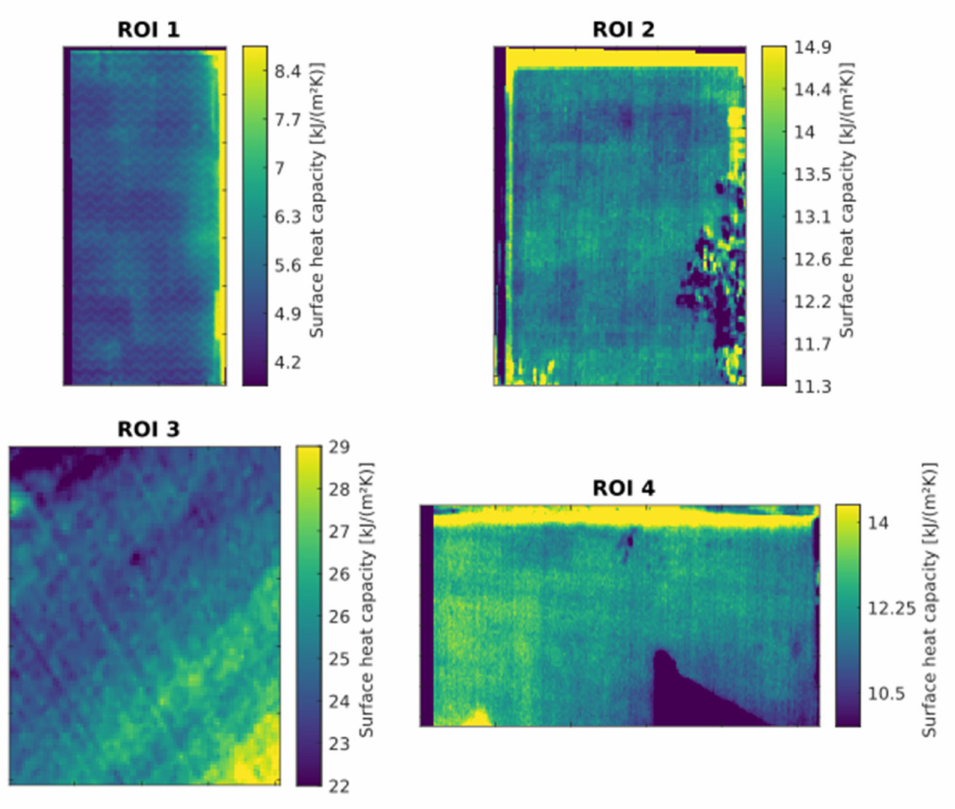
Figure 12. Perspective- and albedo-corrected surface heat capacity